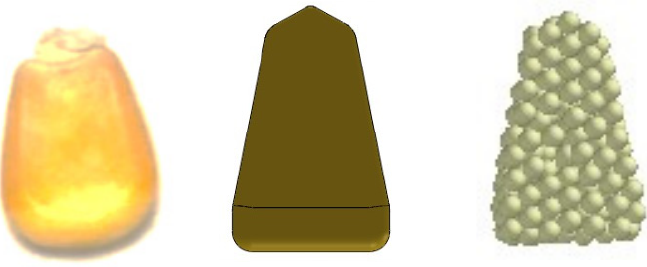
Figure 8. Maize seed simulation model.